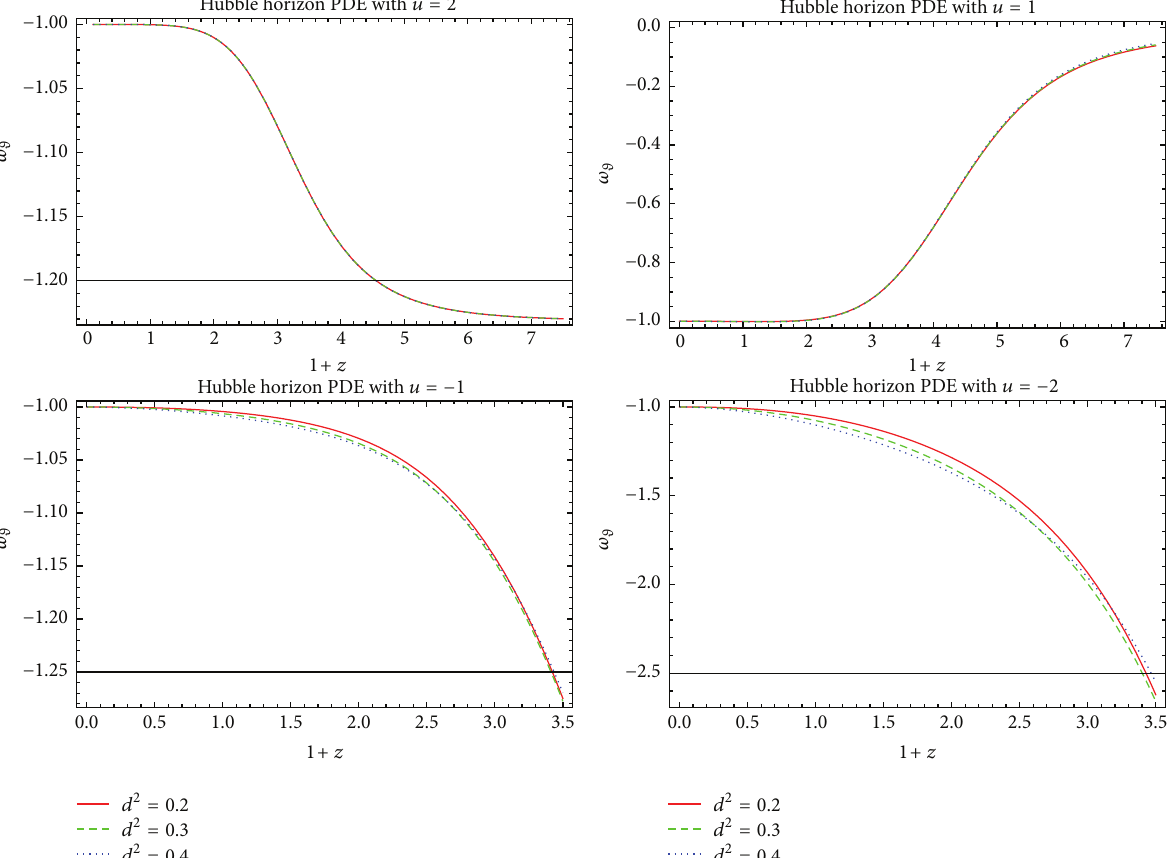
1/𝑢 ⋅𝑛 −2 ) ) + 6 −1/𝑢 ) 𝑢 (1 + 𝑧) −3𝑑 2 (− ((𝑏 2 (1 + 𝑧) 6